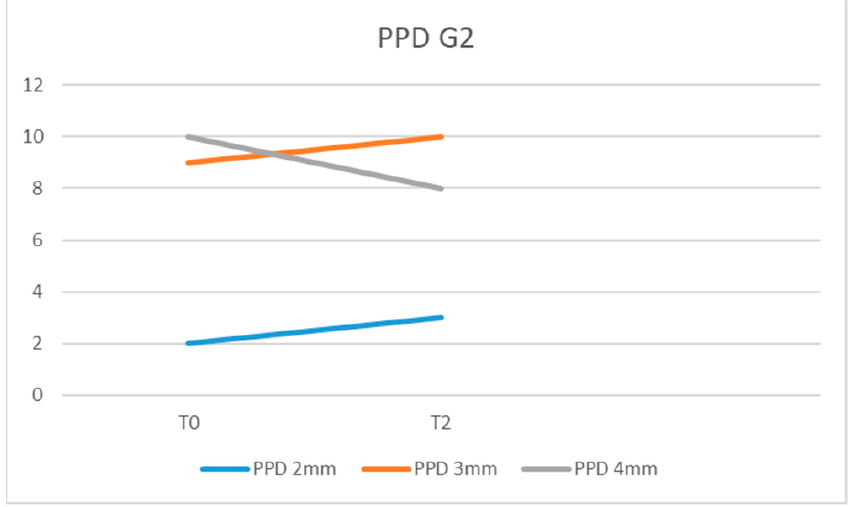
Figure 5. PPD values in G2 at moments T0 and T2 .